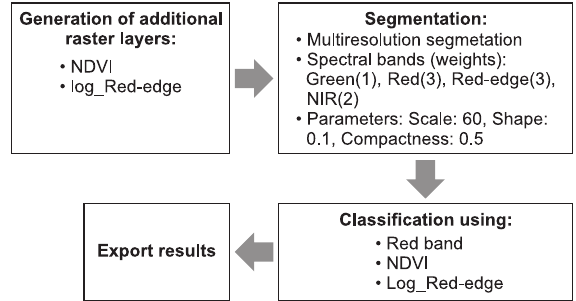
Fig. 2. The flow chart of the GEographic Object Based Image Analysis